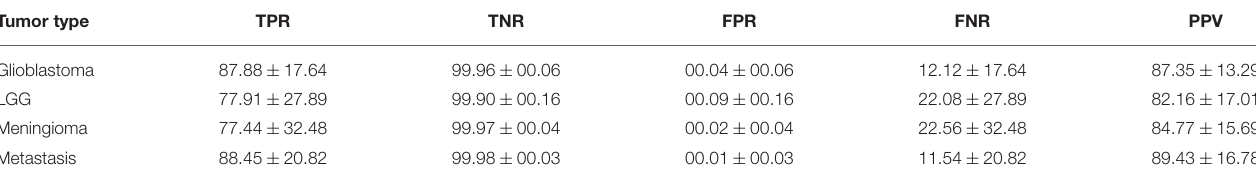
TABLE 4 | Voxel-wise overlap-based metrics performance summary for each tumor type.